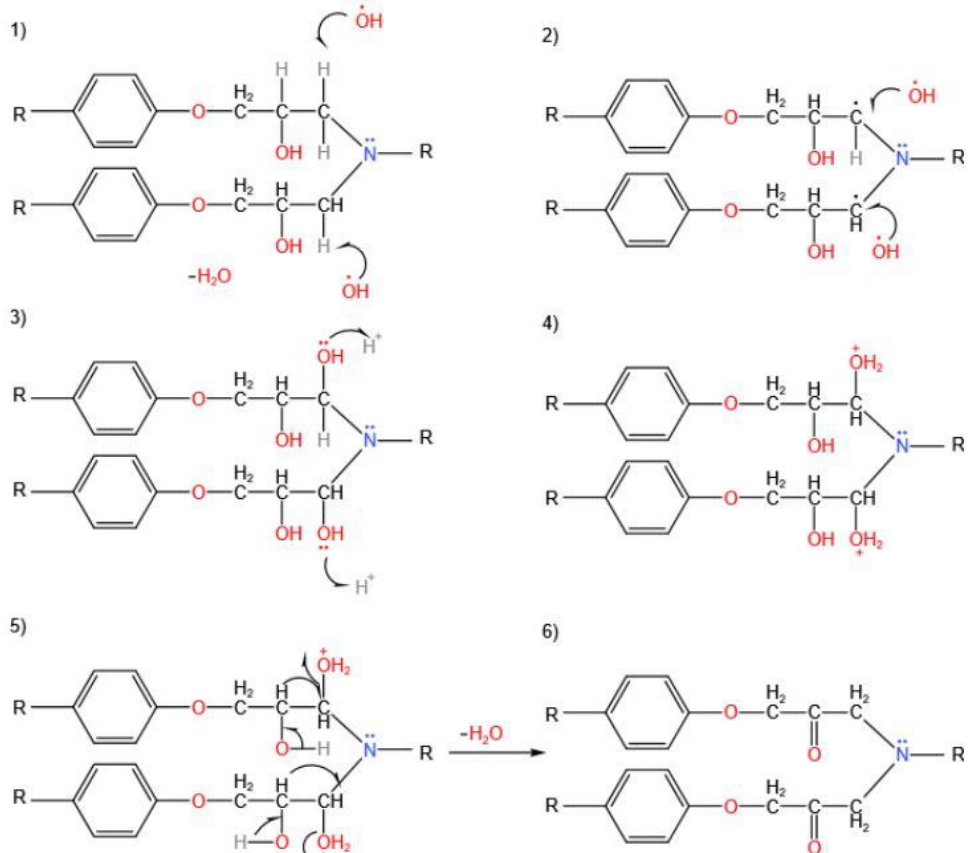
Figure 5. Reaction mechanism of hydroxyl radical with amine crosslinked